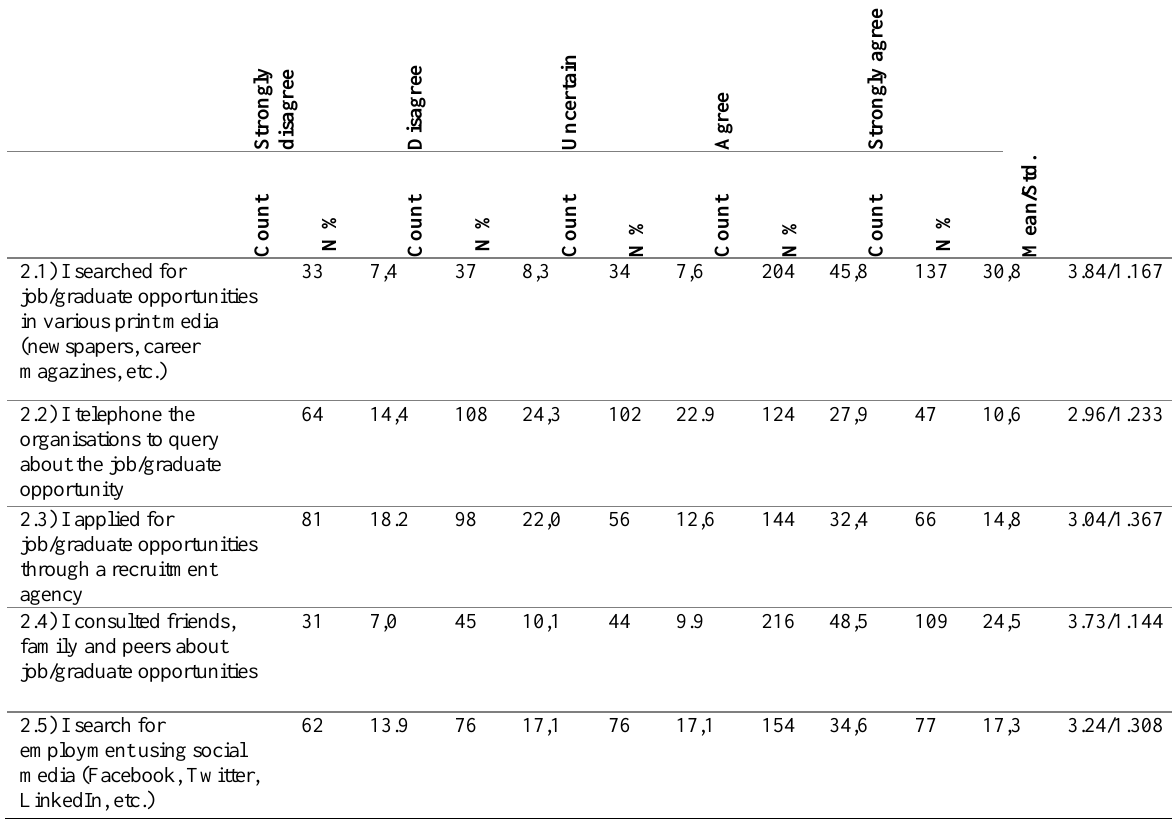
Table 2: Integrated marketing communications